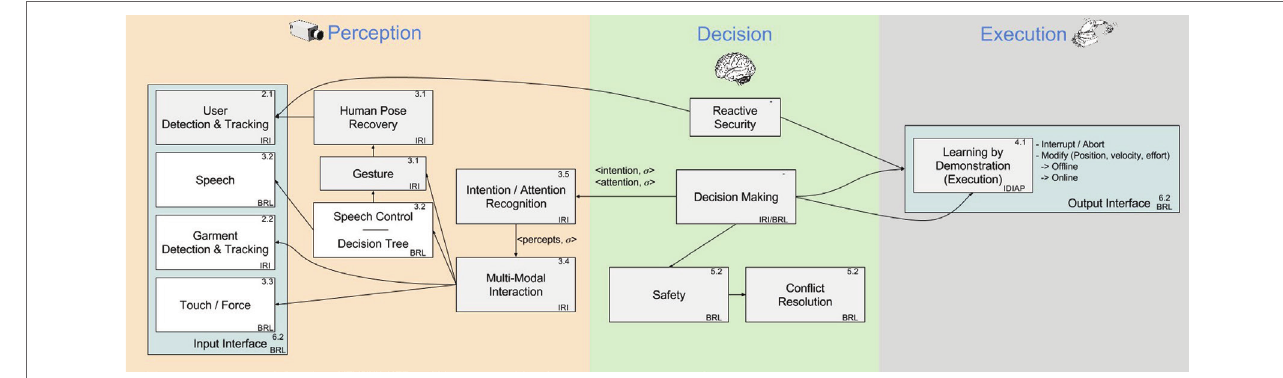
FigUre 2 | i-Dress system architecture . User and garment parameters will influence the control of the robot via the multimodal interaction module and moderated by safety and decision-making